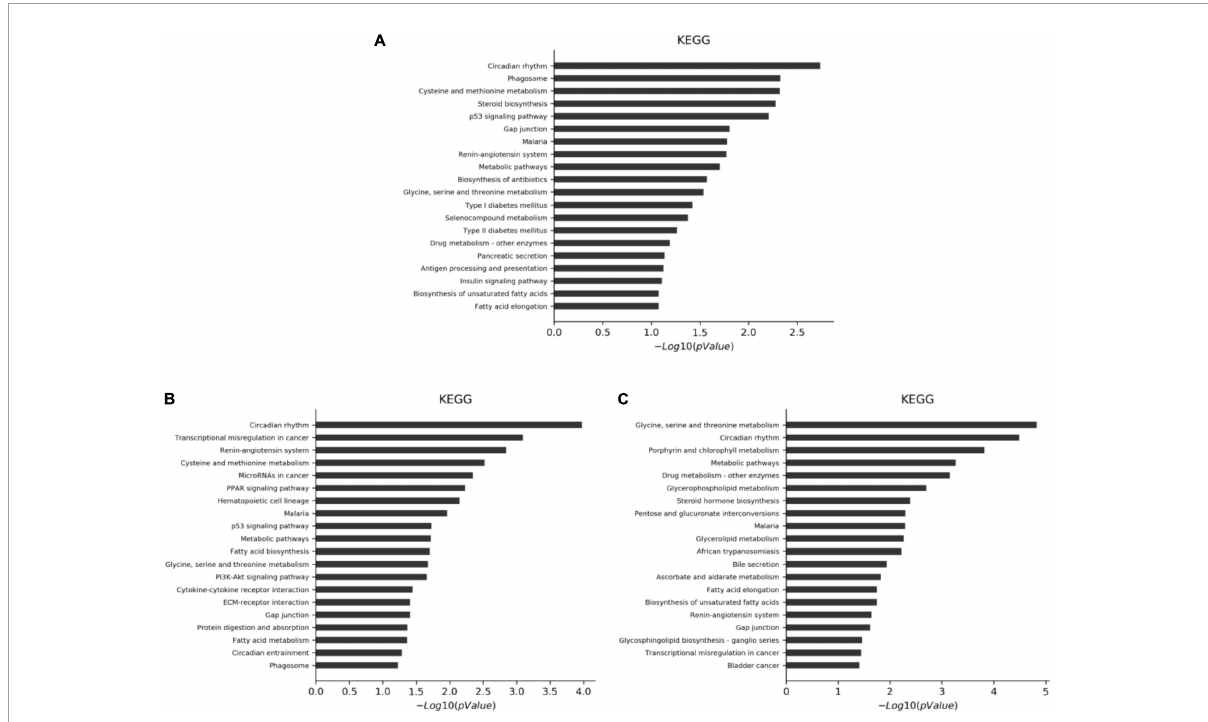
FIGURE4 KEGG analysis of differential gene significant enrichment pathways (top 20). (A) CF group vs. model control group. (B) Luteolin group vs. model control group. (C) Luteoloside group vs. model control group.